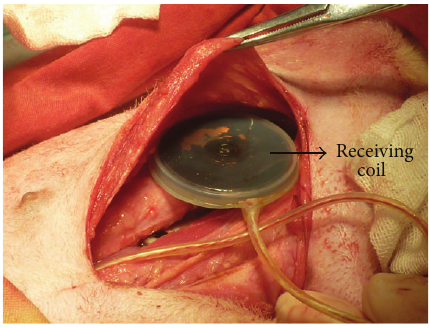
Figure 8: Implantation of the receiving